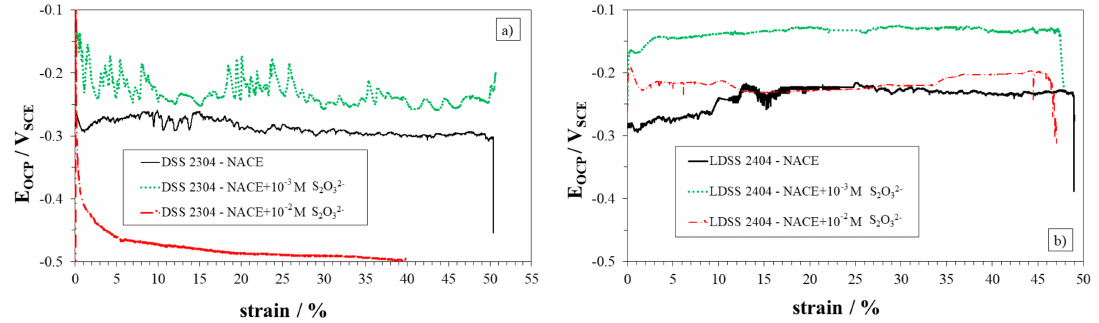
Figure 13. E OCP -strain trends of DSS 2304 ( a ) and LDSS 2404 ( b ) during SSRT in NACE TM-0177 solution at 25 ◦ C and pH 2.7, in the absence and presence of 10 − 3 and 10 − 2 M S 2 O 32 − .